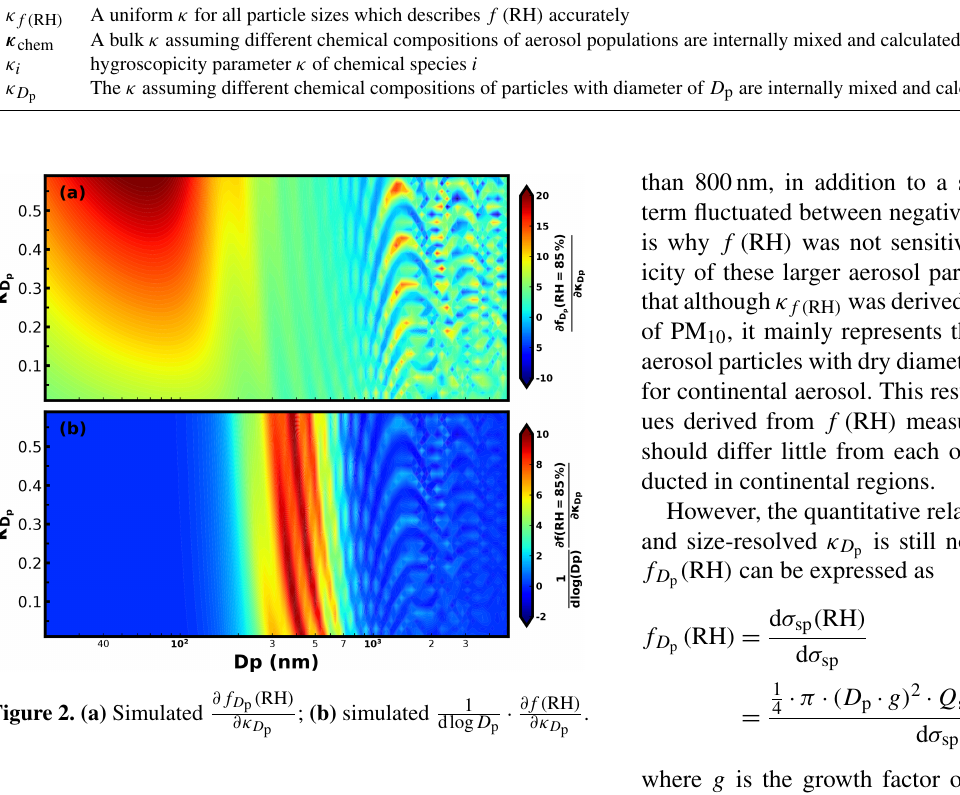
∂f D p ( RH ) ; (b) simulated 1 ∂κ D p